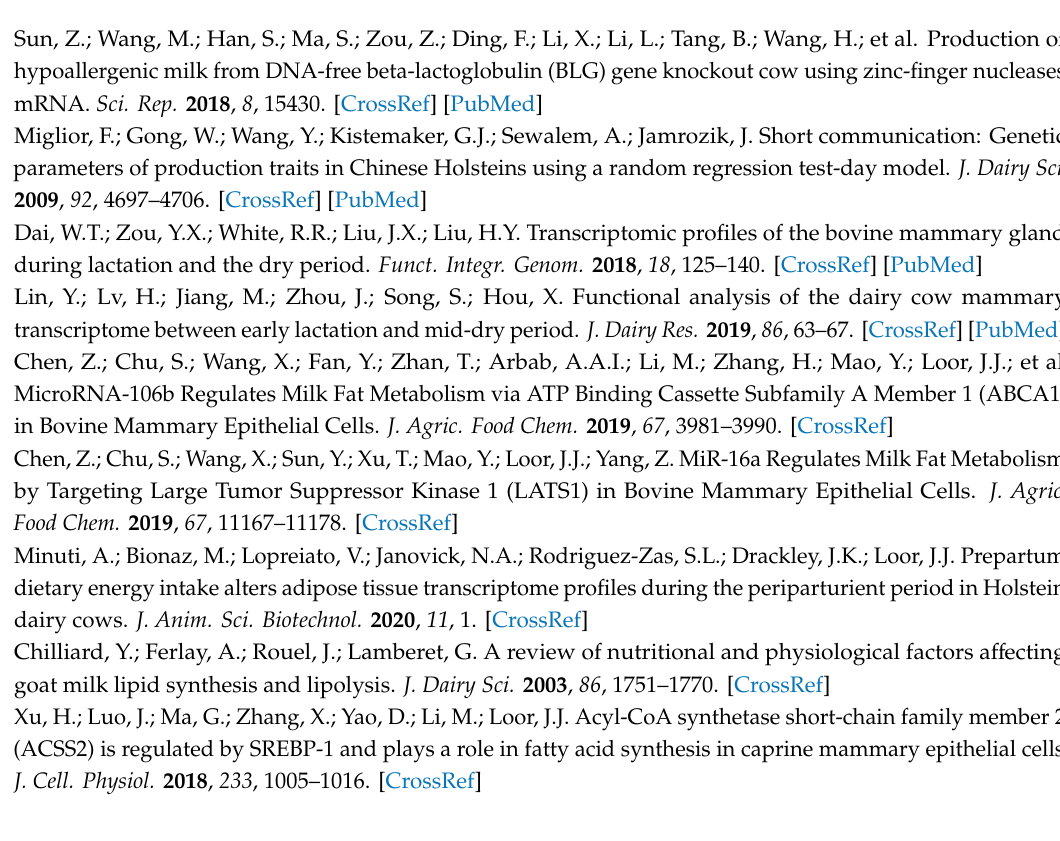
Table S1: Primers used in quantitative real-time PCR to verify transcriptome sequencing data. Table S2: Primers used in PCR for the target fragment cloning. Table S3: Primers used in quantitative real-time PCR to detect genes expression levels of bovine mammary epithelial cells. Figure S1. Histological observation of the samples for transcriptome analysis. Table S4: Milk yield, milk lactose, milk fat, milk protein, somatic cell count, and somatic cell score in di ff erent test days. Table S5: The quality parameters of total RNA. Figure S2. The electropherogram image of total RNA. Table S6: Statistics of sequencing reads and mapped reads. Figure S3. The saturation for the six libraries. Figure S4. A protein–protein interaction network of DEGs. Figure S5. Agarose gel electrophoresis of DNA